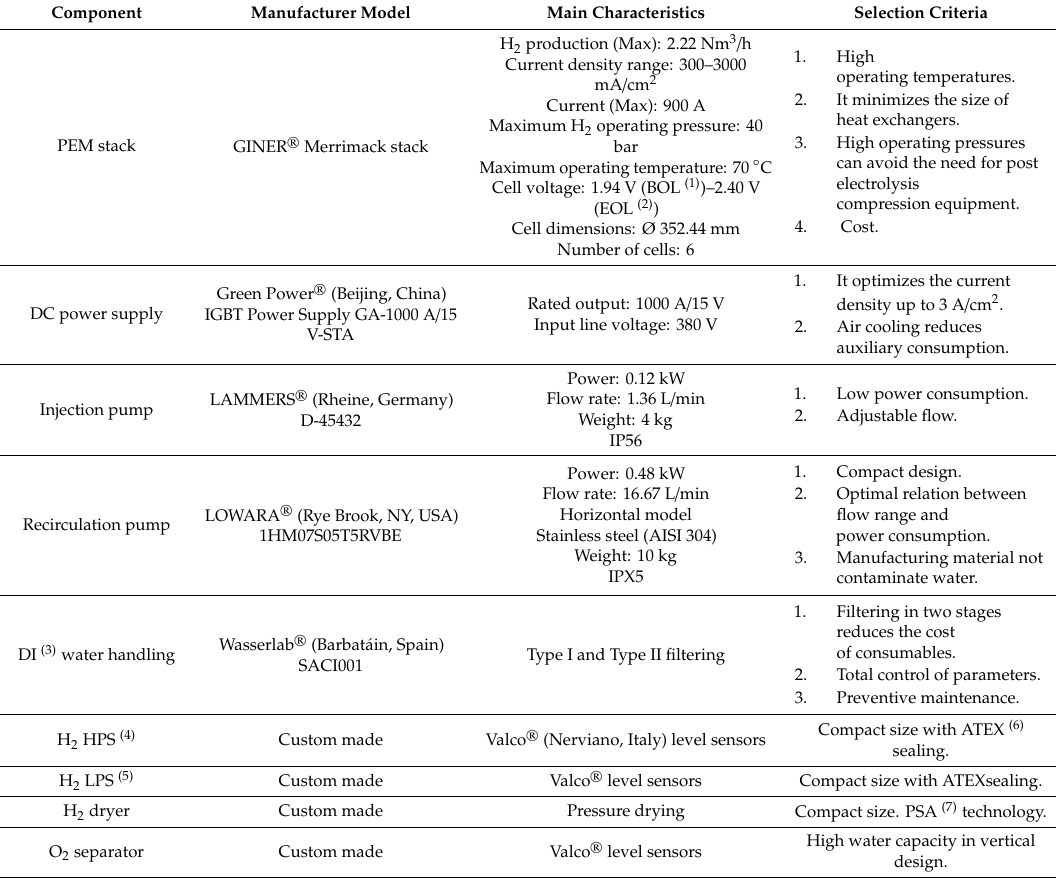
Table 3. Balance of plant (BoP) implementation. Technical characteristics and selection